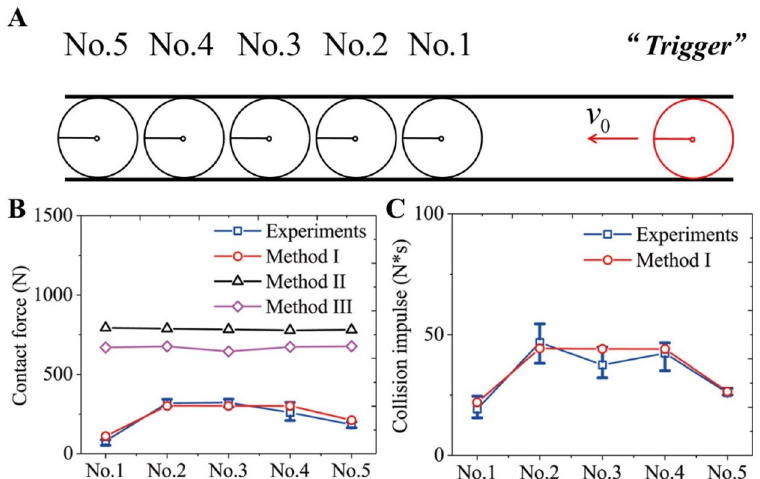
Figure 2. Successive collision simulations in a single-person width corridor. ( A ) Illustration of the simulation scenario. All the individuals were set as circular with r = 0.2 m 31 . The No.1 to No.5 individuals remained stationary with an interval of 0.05 m, and the "Trigger" at the rear moved forward and hit the individual in front with v 0 = 0.35 m/s. In order to be consistent with the experiments, the social forces between individuals and the driving forces of the No. 1 to No. 5 individuals were ignored. Therefore, the movements of the No. 1 to No. 5 individuals were driven only by the physical contacts. ( B ) The contact forces of all individuals were obtained by three methods and experiments. Method I: The physiological acceleration limits of all individuals were assumed to be a upper = 5 m/s 2 , and the physical contacts between individuals were modeled based on the collision impulses and pushing forces. Method II: The physiological acceleration limits were assumed to be a upper = 5 m/s 2 , and the physical contacts between individuals were modeled based only on the pushing forces. Method III: No physiological acceleration limits existed, and the physical contacts between individuals were modeled based only on the pushing forces. ( C ) The collision impulses of all individuals were obtained by simulations and experiments. The successive collision impulses transmitted along the queue were not conserved due to the change of individual body posture and they could be amplified or attenuated. In the above simulations, the parameters related to the pushing forces were k ′ = 1 × 10 5 kg · s − 2 and κ ′ = 1 × 10 5 kg · m − 1 · s − 1 . In fact, the simulation results of Method I did not change if the parameters were changed, but the simulation results of Methods II and III changed significantly. If the parameters changed, the contact forces could decrease, but this would lead to excessive penetrations between individuals and aberrant high local densities at the same time. See SM for a detailed